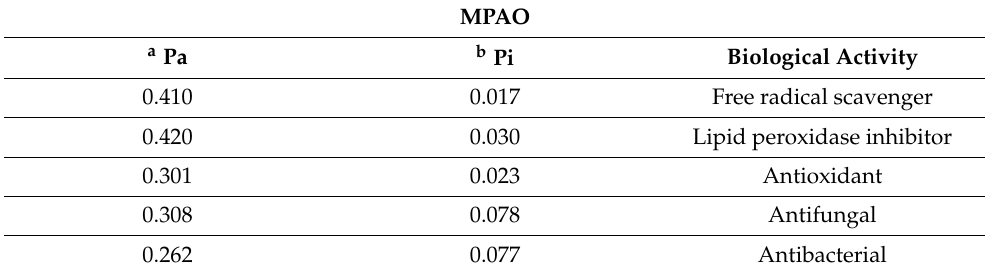
Table 4. Part of the predicted biological activity spectra of the MPAO based on PASS prediction software.